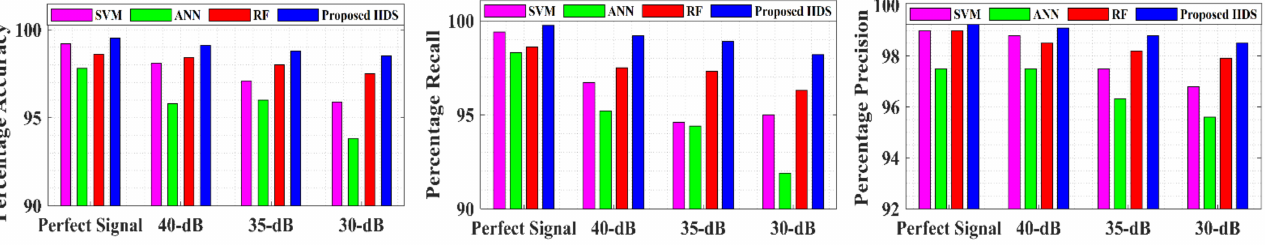
Figure 8. Performance of the proposed IIDS on modified IEEE-34 node test